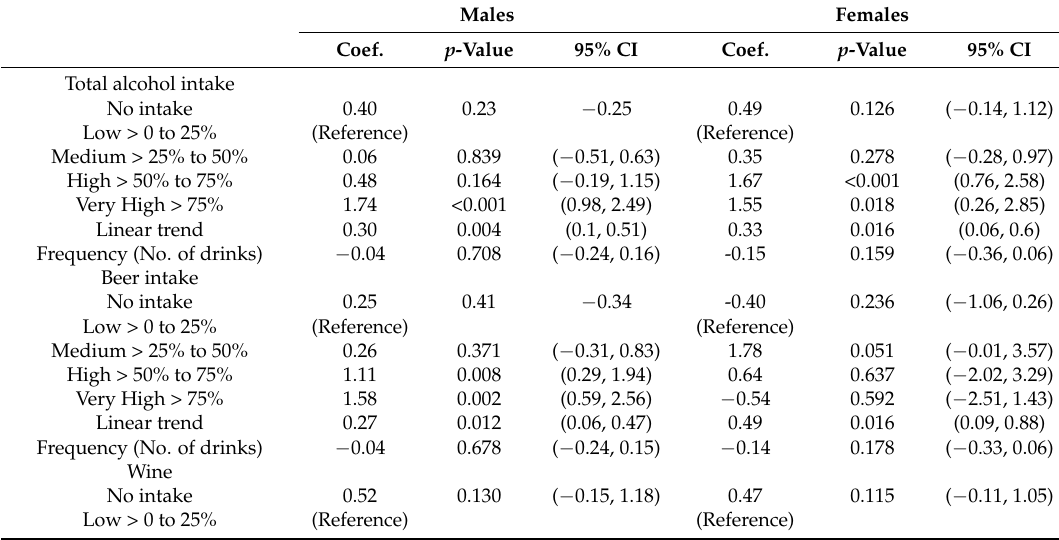
Figure 1. Relationship of BMI to category of intake of energy from alcohol on the heaviest drinking day (%RDA Energy) in men ( a ) and women ( b ). Table 5. Relationship between BMI and category of intake of energy from alcohol on the heaviest drinking day (%RDA Energy in